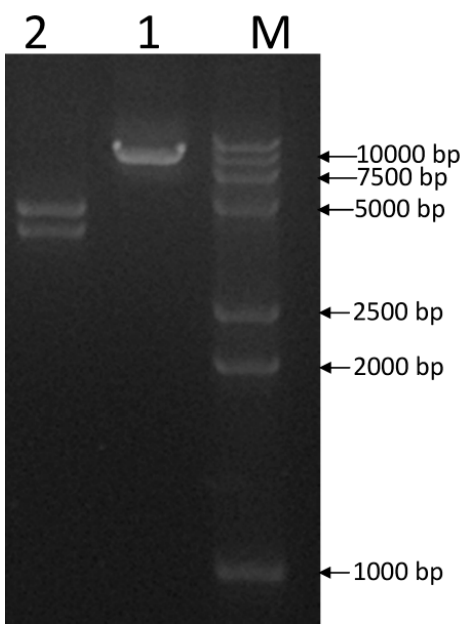
Figure 2. The products of recombinant plasmid pGcry2A0229 digested by restriction enzymes: M, DL15,000 + 2, 000 DNA ladder; 1, The products of pGcry2A0229 digested by Hin d III; 2, The products of pGcry2A0229 digested by Hin d III and Eco R I.